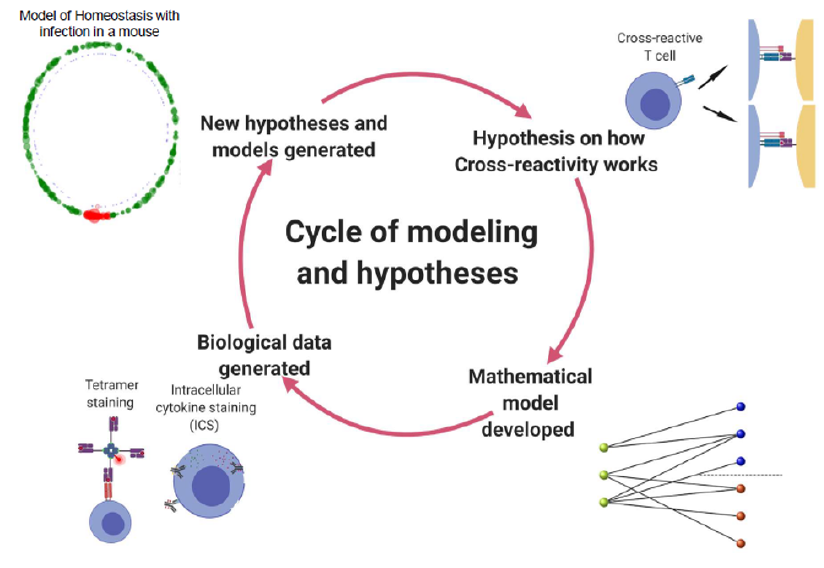
Figure 3. The cycle of mathematical modeling and the investigation of TCR